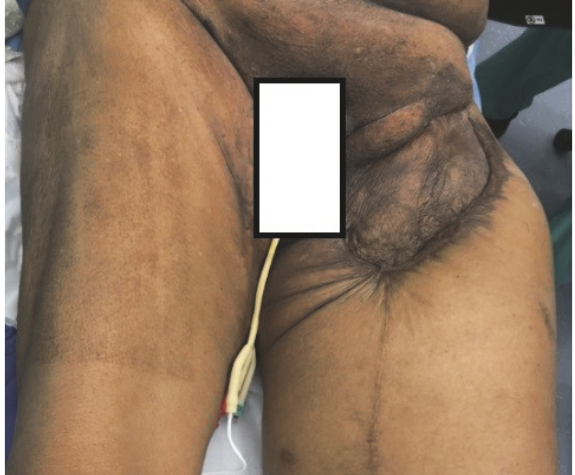
Figure 3: Left thigh of the patient on physical